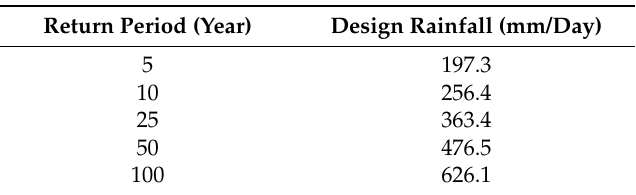
Figure 5. Water level gauging stations in the Metro Colombo canal basin. Table 1. Daily design rainfalls in the study area.